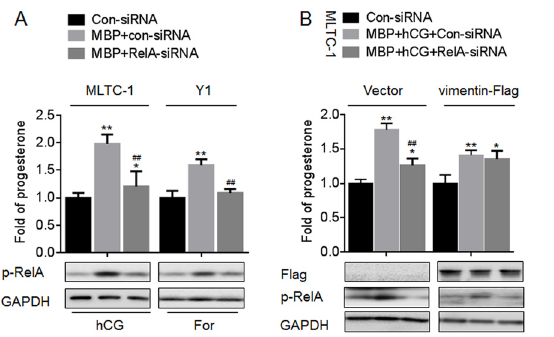
Fig 9. Effects of NF- κ B/vimentin signaling on the MBP-induced progesterone secretion in vitro . (A) MLTC-1 and Y1 cells were treated as described in Fig 8E, the secretion of progesterone was determined in triplicate (top), and the expression of p-RelA was determined by Western blot (bottom). The amounts of progesterone measured in control cells were MLTC-1: 8.23 ± 0.24 ng/ml, Y1: 9.42 ± 0.37 ng/ml, respectively. (B) After MLTC-1 cells were co-transfected by Con-siRNA or RelA-siRNA plus Vector or vimentin-Flag construct for 12 h, they were exposed to 1000 nM MBP for 24 h. The secretion of progesterone was determined in triplicate (top), and the expressions of Flag and p-RelA was determined by Western blot (bottom). The amounts of progesterone measured in control cells were MLTC-1 (vector): 9.02 ± 0.31 ng/ml and MLTC-1 (vimentin-FLag): 10.56 ± 0.53 ng/ml, respectively. * p < 0.05 and ** p < 0.01 compared with medium control cells; ## p < 0.01 compared with cells exposed to MBP plus